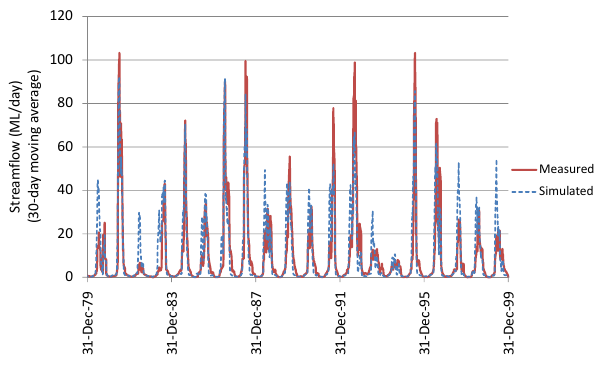
Fig. 4. Observed and simulated streamflows in the calibrated GWLF